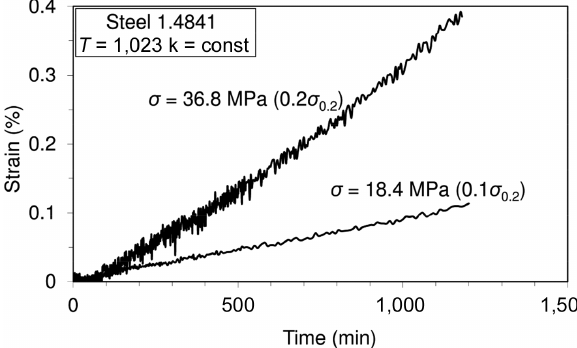
Figure 6: Creep behaviour of steel 1.4841 at a temperature of 1,023